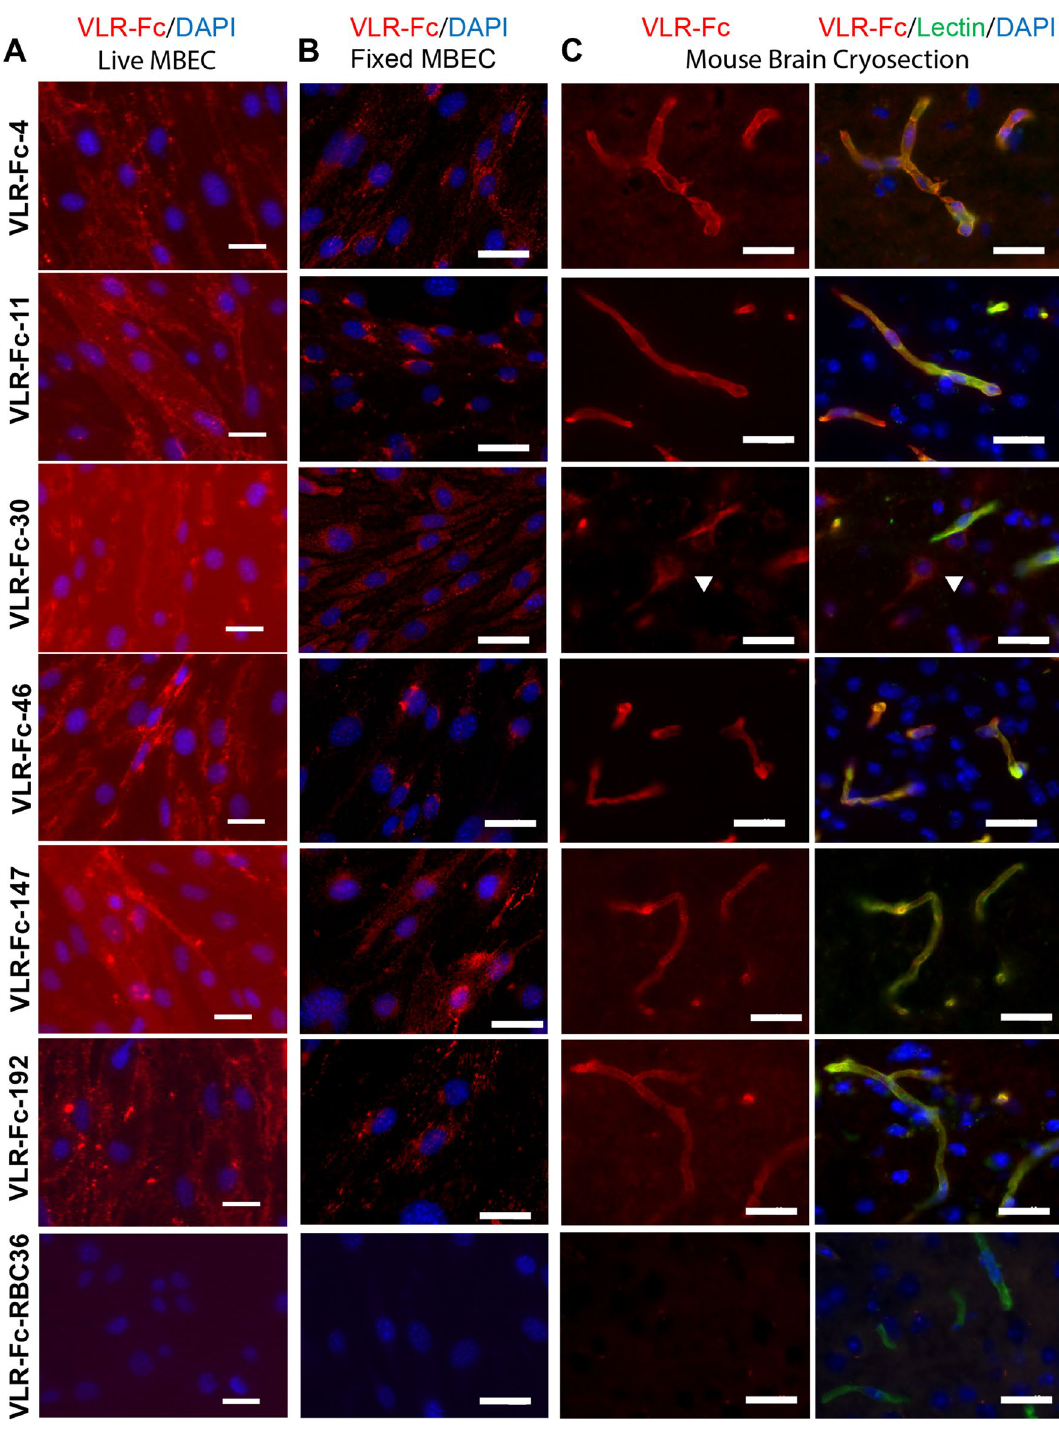
Figure 4. BBB binding profiles for individual VLR clones. VLRs were produced as VLR-Fc fusions and used for immunolabeling (red) of ( A ) Live MBECs, ( B ) Fixed and permeabilized MBECs, and ( C ) Mouse brain cryosections. Labeling with IB 4 -lectin is used to denote the location of microvessels (green). VLR-Fc-RBC36 was used as an isotype control. A white arrowhead highlights binding of VLR-Fc-30 to parenchymal cells. In panels A-C, DAPI (blue) is employed as a nuclear counterstain. Scale bars = 25